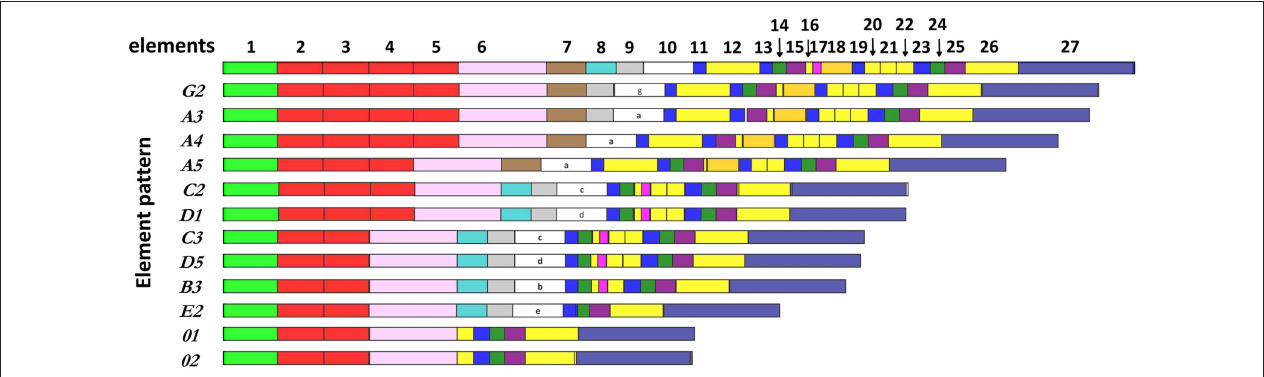
FIGURE 1 | The SpTrf genes have a variety of element patterns. Element patterns identified for the genes amplified and sequenced in this study are shown. Elements are presented as rectangles of different colors. Element 10, which has very diverse sequence among genes, defines the gene name (4). This figure is based on data from Buckley and Smith (8).